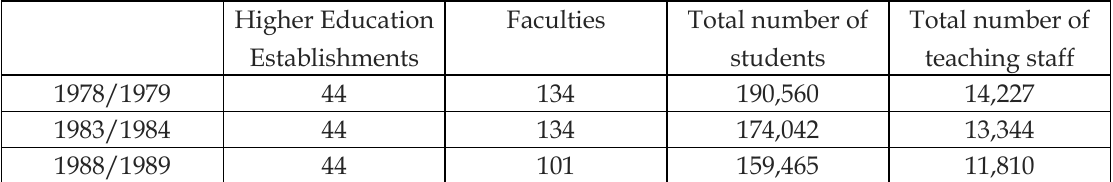
Table 1. Quantitative evolution of high education in Romania,